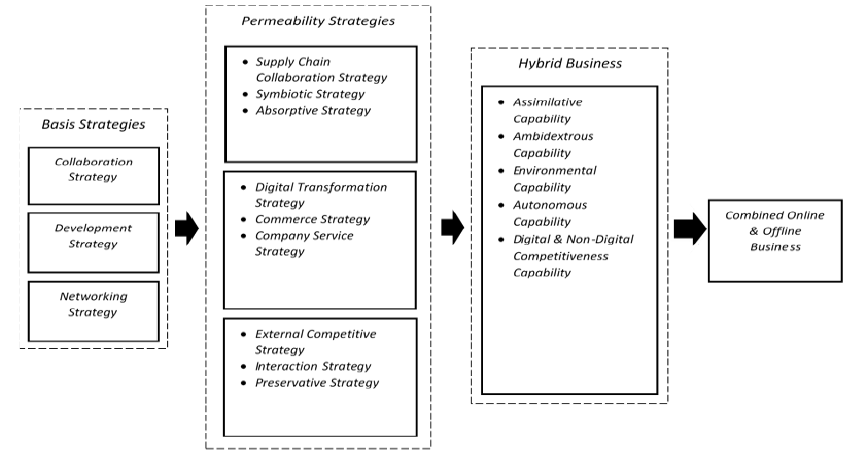
Figure 1: Combined Online and Offline